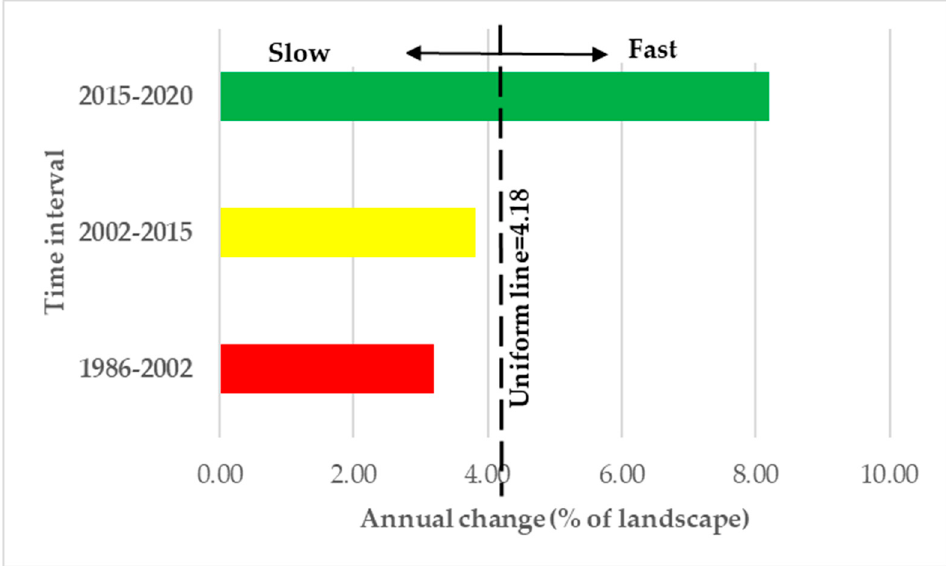
Figure 5. Interval level intensities for 1986–2002, 2002–2015 and 2015–2020.